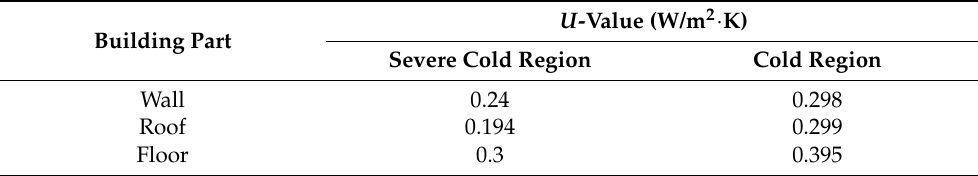
Table 4. U -values of envelope under the NZEB standard.